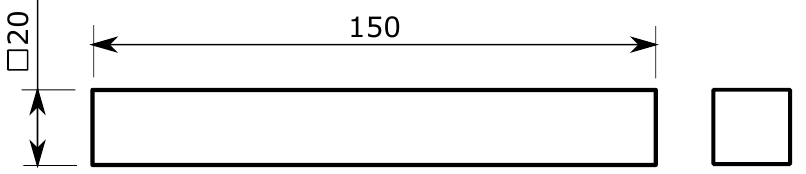
Figure 4. Square cross-section specimen for the bending test (units in